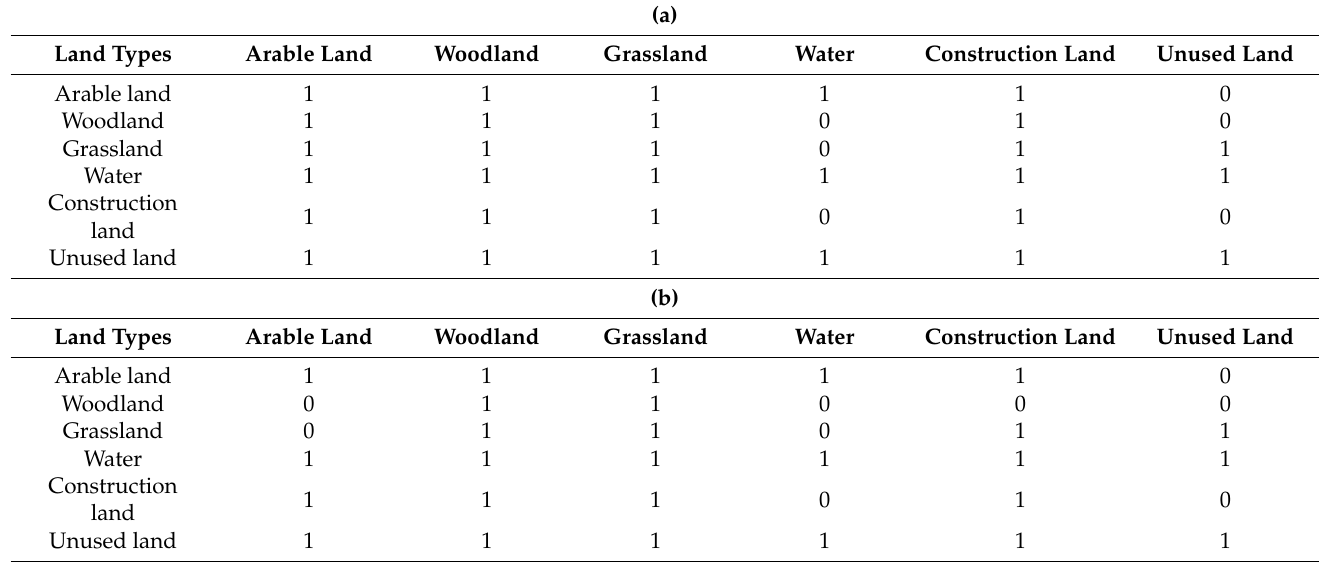
Table 3. ( a ) Land transfer parameters under the natural development scenario. ( b ) Land transfer parameter under the ecological security